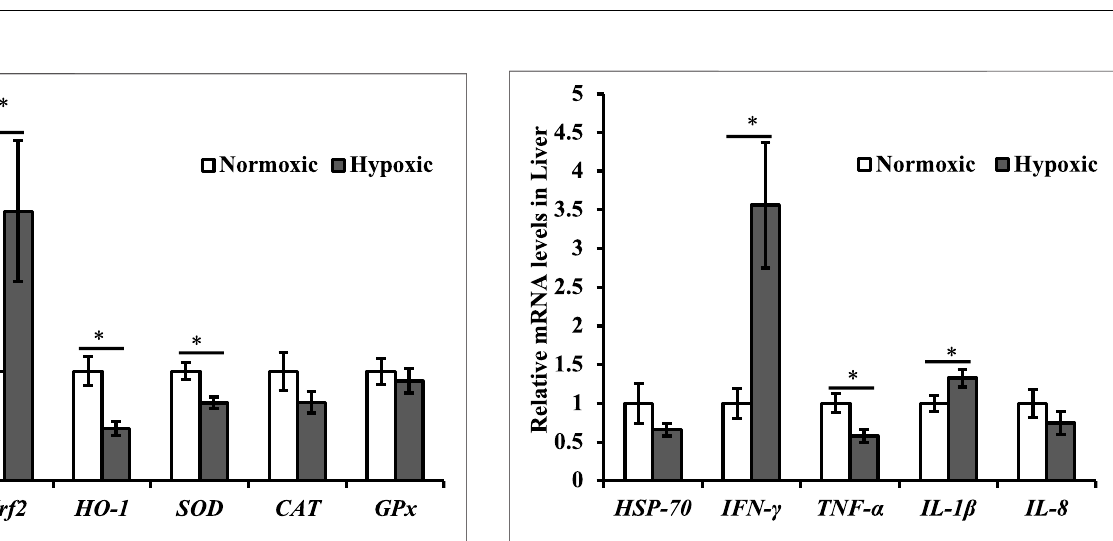
FIGURE 2 | Effect of acute hypoxic stress on the malondialdehyde (MDA) content in the plasma (A) and liver (B) as well as the total antioxidant capacity (T-AOC) level in the plasma (C) and liver (D) of triploid rainbow trout ( n = 6). Asterisks indicate the signi fi cant differences ( t -test; * p < 0.05; ** p < 0.01).